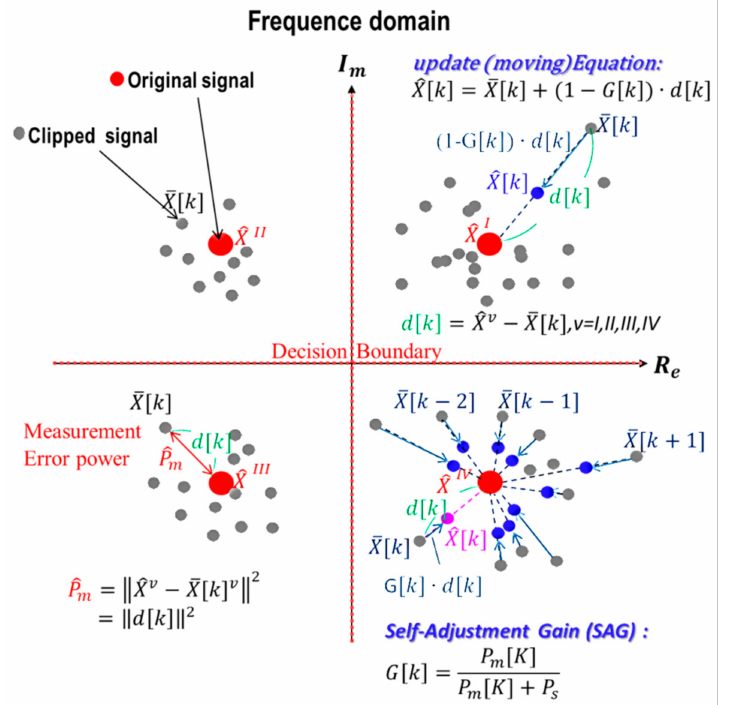
Figure 4. Constellation adjustment by the proposed SAG method for QPSK–OFDM